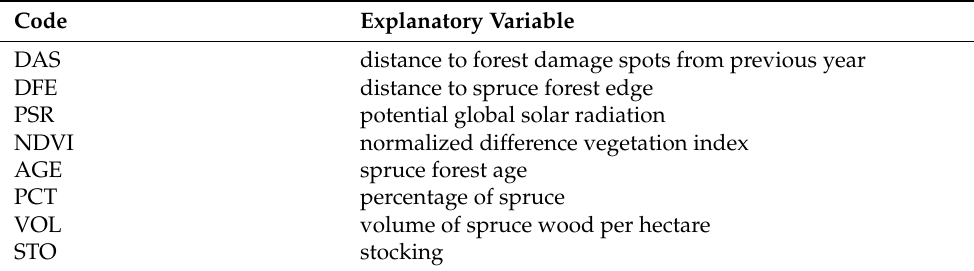
Table 1. List of the explanatory variables used in forest damage models (FDMs).